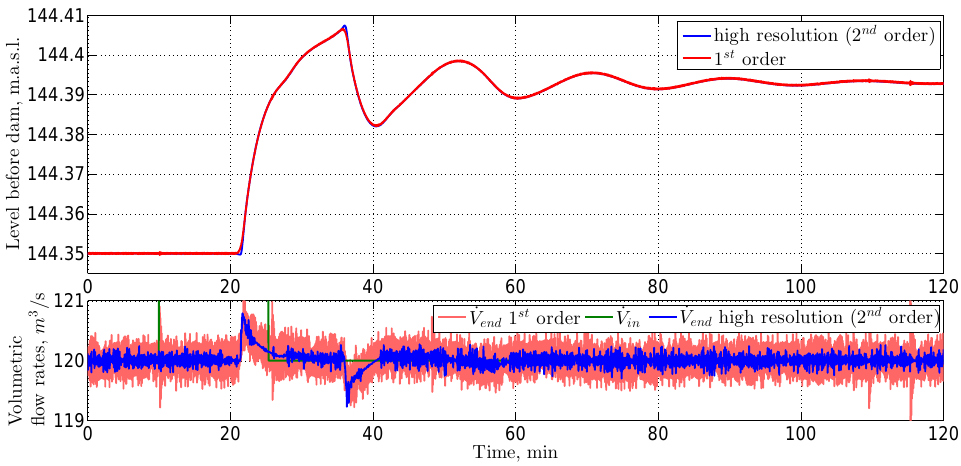
Figure 4: The results of simulating the model with two methods, using the ode23 solver.